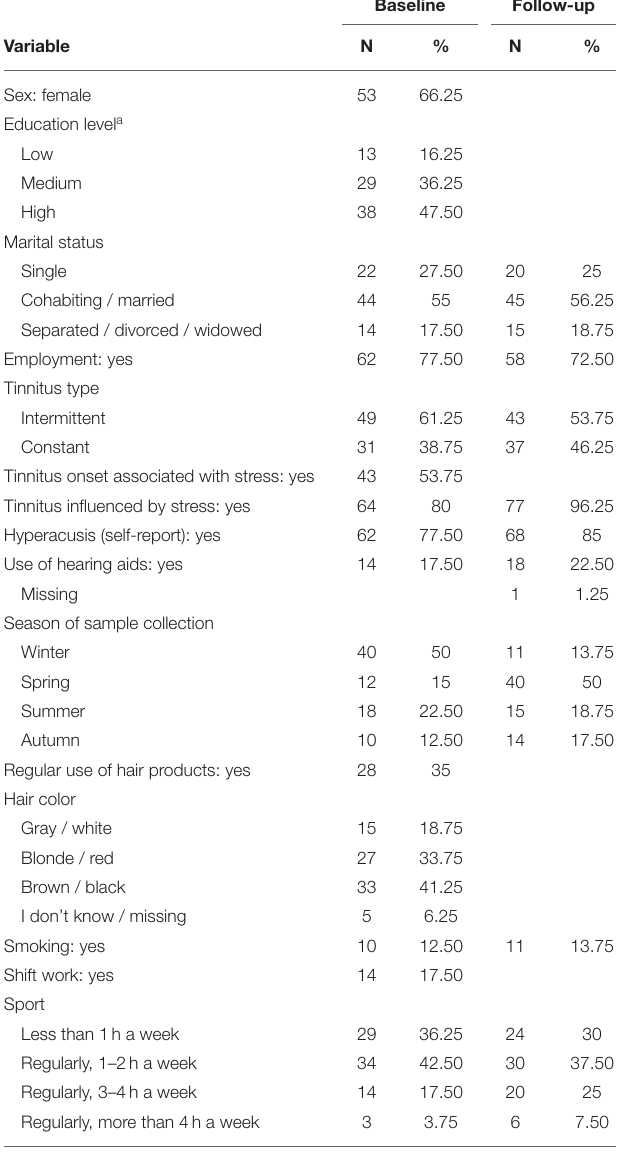
TABLE 2 | Summary statistics of categorical variables ( N =